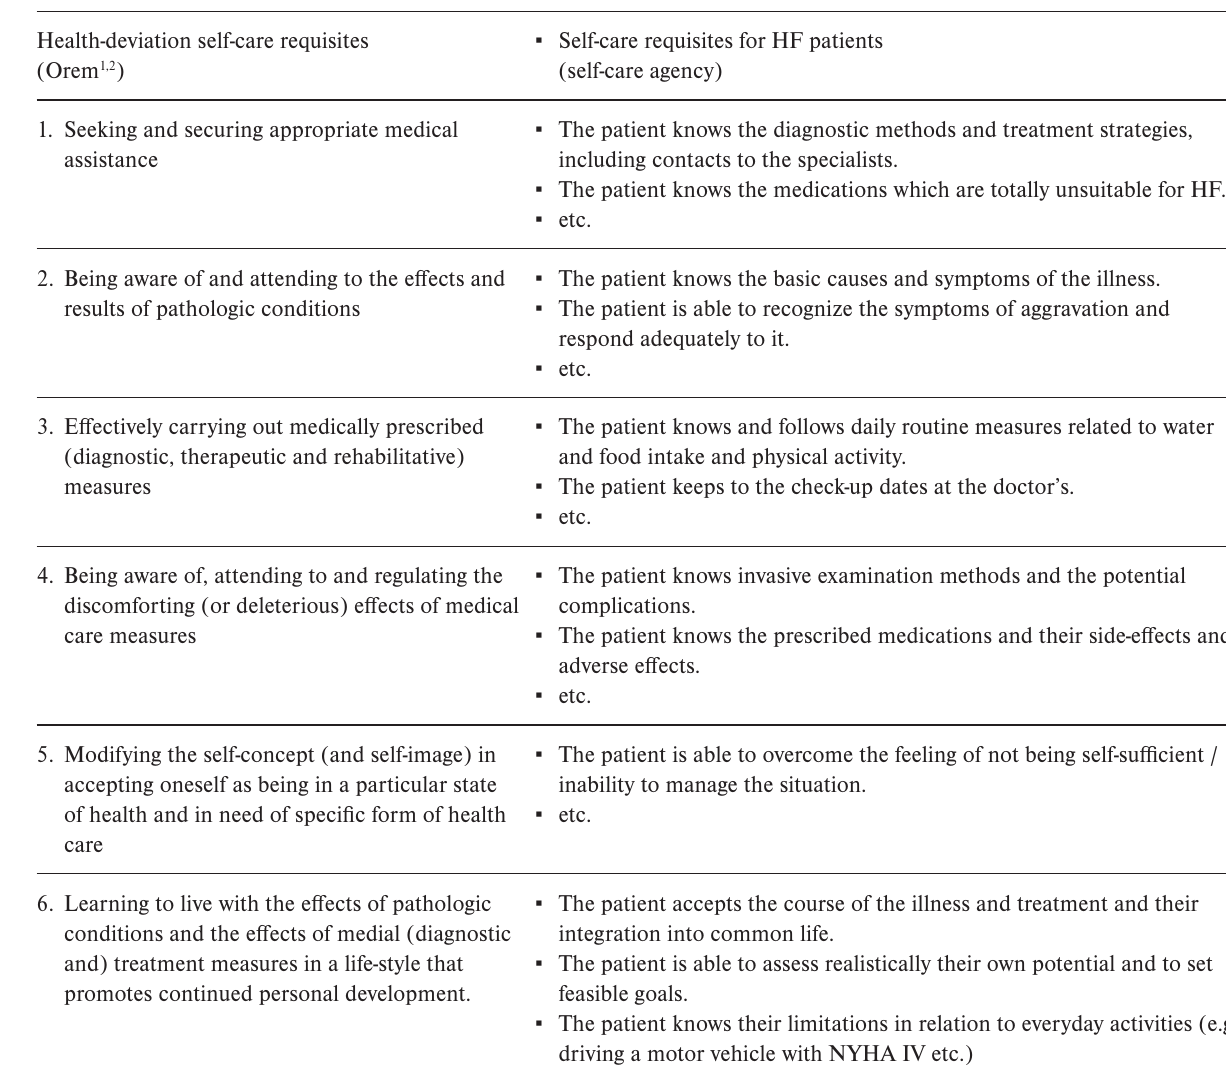
Table 2. Therapeutic self-care demand with chronic heart failure